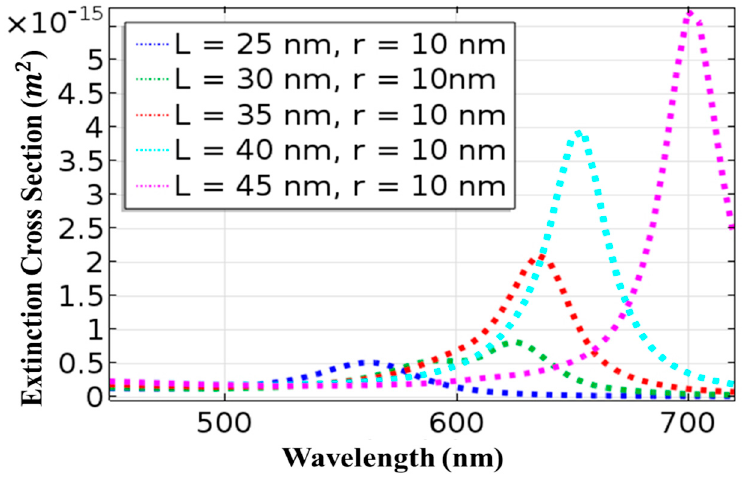
Figure 3. Extinction cross-section of gold nanorods under p-wave illumination.